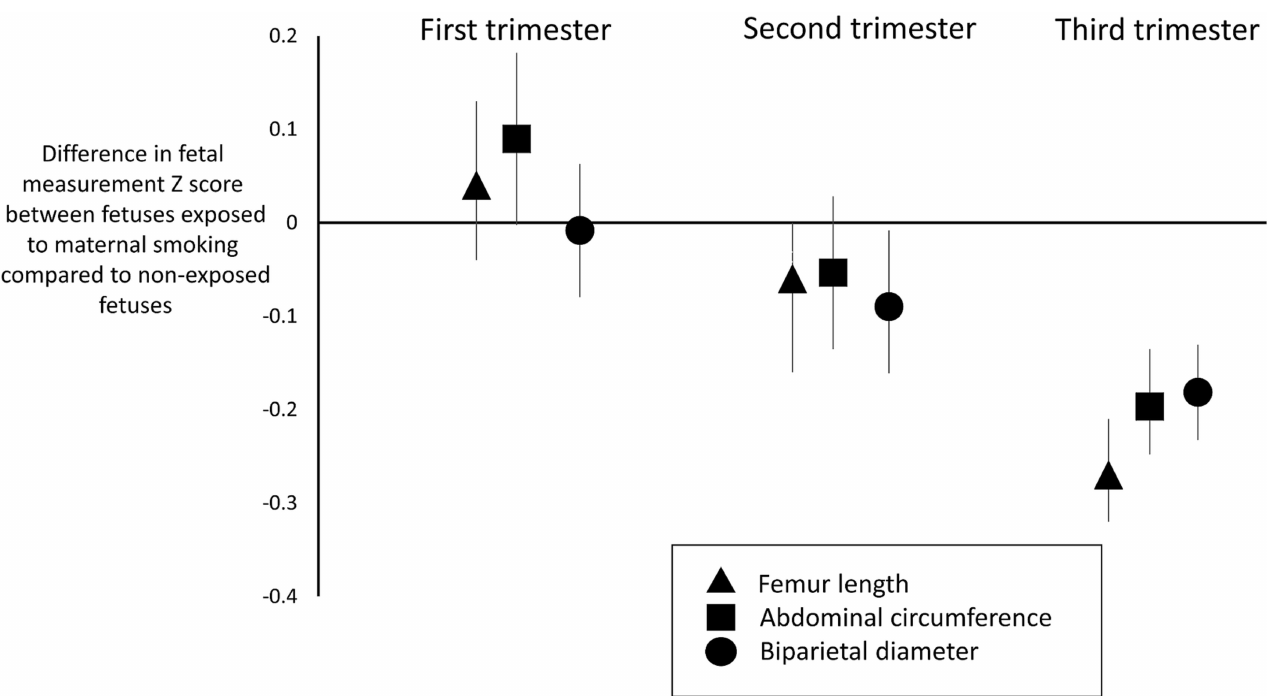
Fig 2. Mean z scores for femur length, abdominal circumference and biparietal diameter for fetuses exposed to maternal smoking relative to non-exposed fetuses. The vertical lines correspond to 95% confidenceintervals.